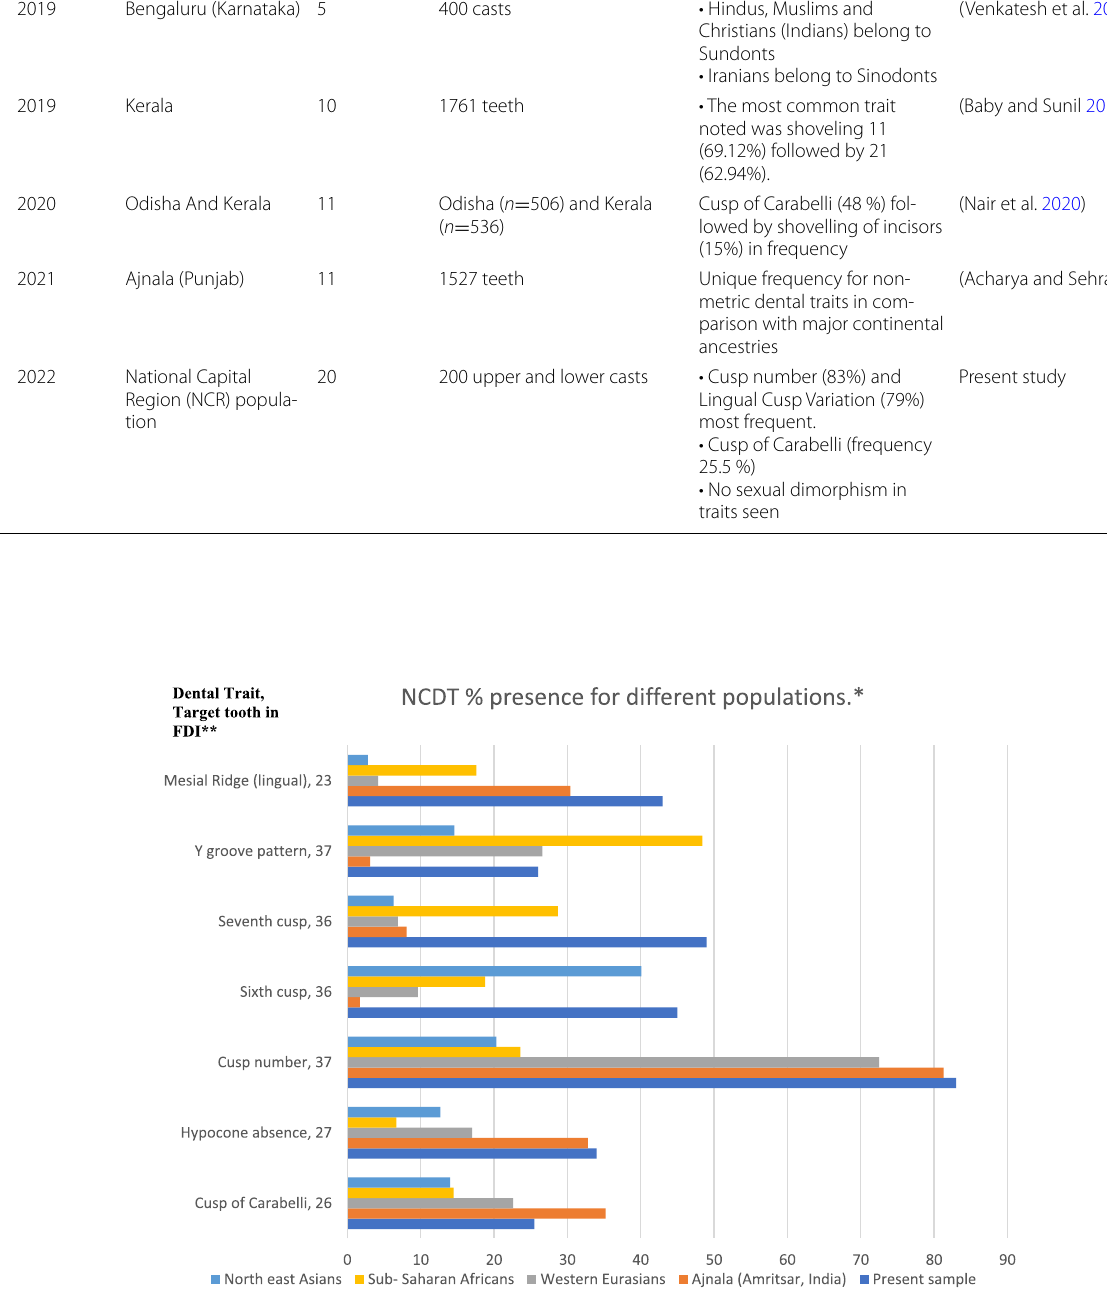
Fig. 2 Comparative frequency distribution (%) of 7 NCDTs in 5 different populations*. *Adopted from Acharya and Sehrawat 2021, **Fédération Dentaire Internationale (FDI)